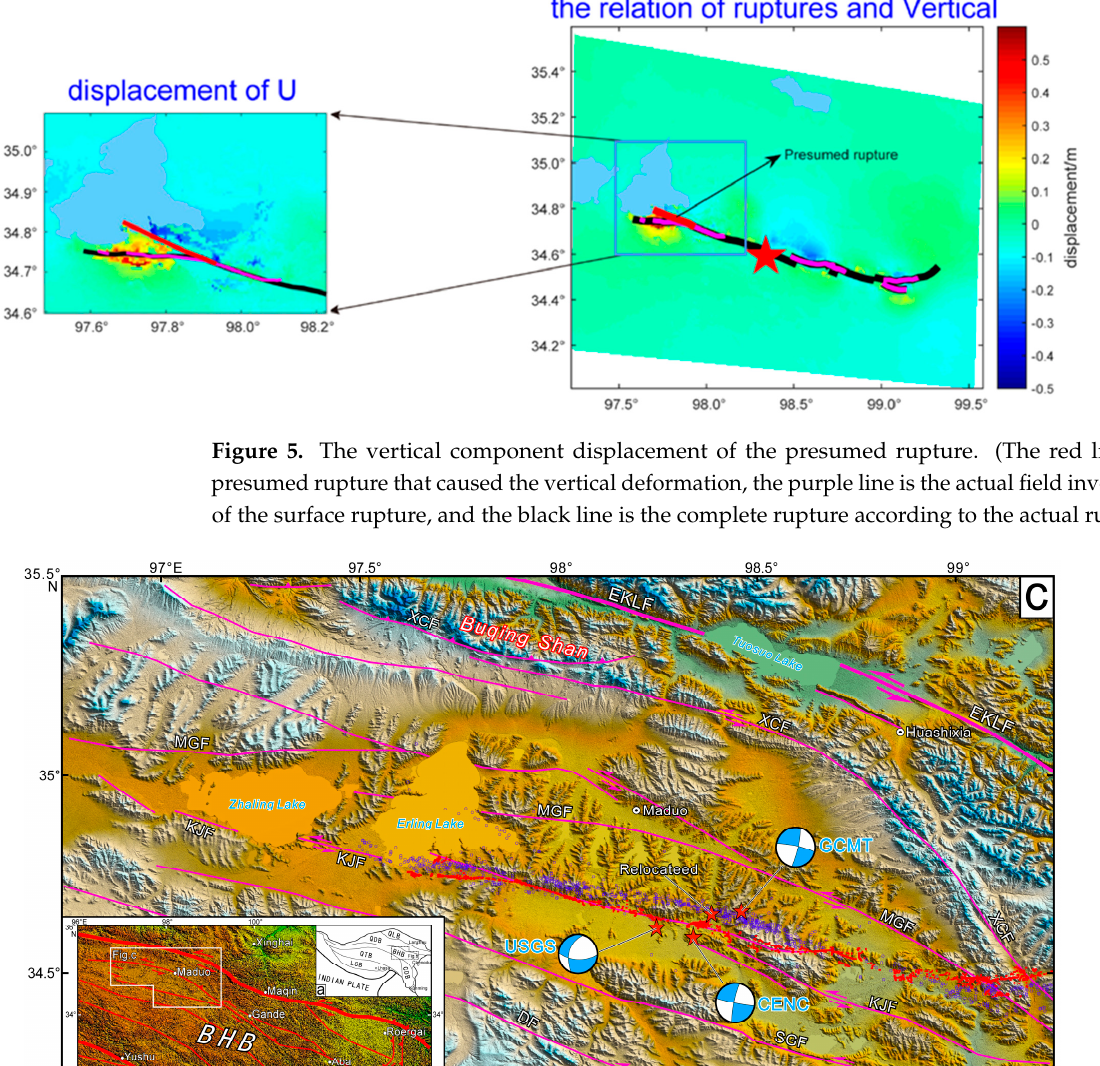
Figure 6. The distribution map of the NW–NWW strike pre-existed faults near the 2021 Maduo M S 7.4 earthquake and its vicinity [55,66–68,71,72]. ( a ) is the tectonic unit of the Qinghai-Tibet Plateau. ( b ) is the distribution map of active faults in and around the Bayan Har Block, ( c ) is the specific tectonic location and active faults of the white box in ( b ): BHB—Bayan Har Block, LSB—Lhasa Block,